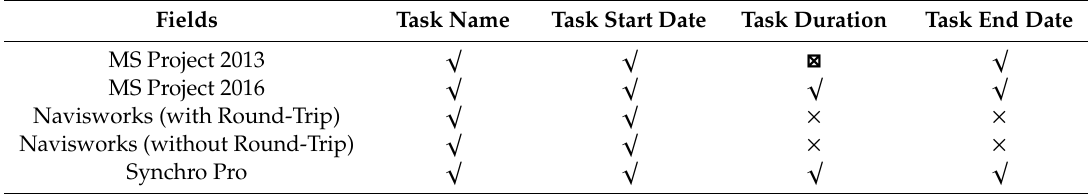
Table 7. Results of tests of BIM interoperability through Gantt Charts—Management2Design, obtained by exporting sample Gantt charts by CPM software packages to Tekla Structures ( interoperability; (cid:2) : medium interoperability; × : poor